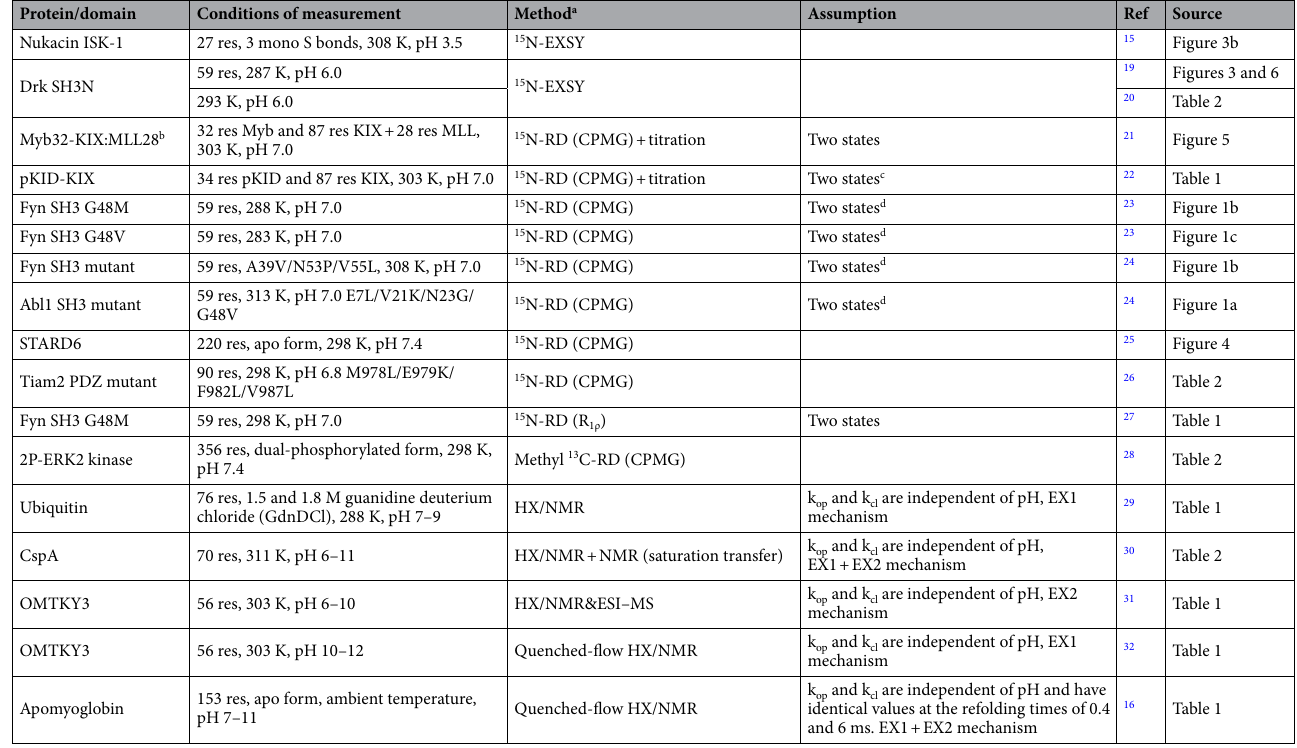
Table 1. Proteins used for the generation of REFER plots. a Relaxation dispersion (RD) experiments